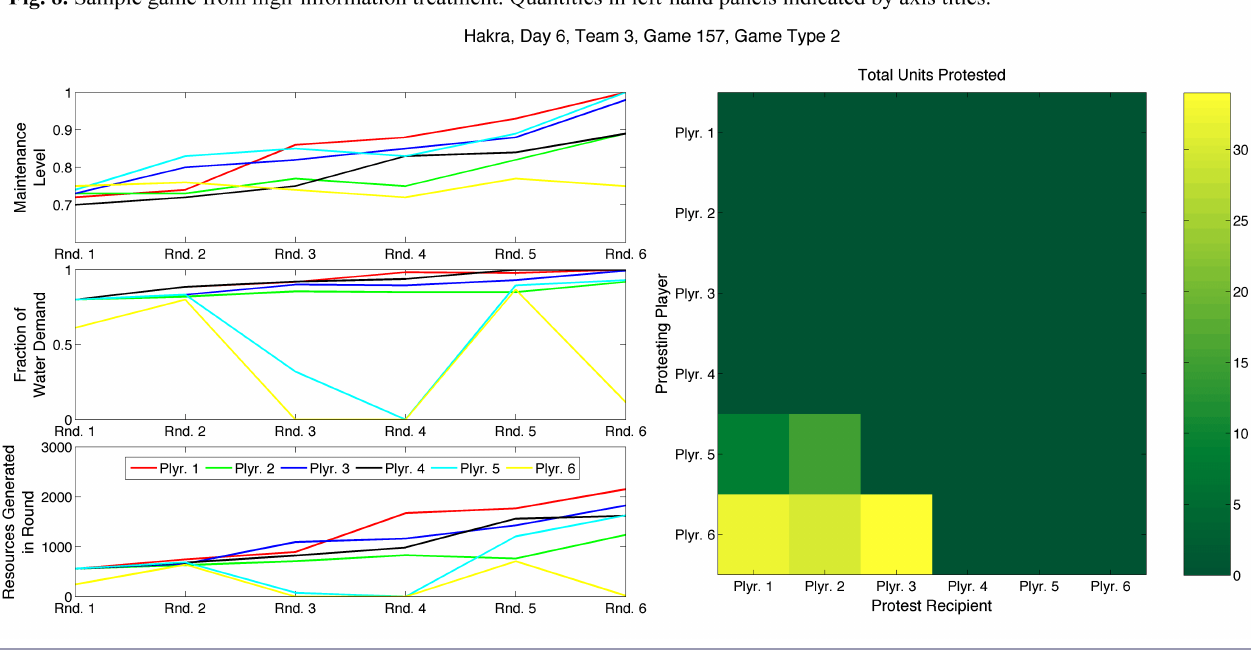
on average across the system by the end of the sixth round. A “heat map” of the sum of units of allocated water protested is shown at the right in each of Figures 7 and 8; row elements in these maps correspond to the player protesting, and column elements to the player whose allocation is being protested.